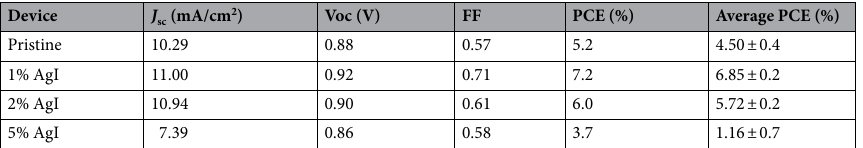
Table 1. Summary of PV parameters of the best performing devices together with the average PCE of the pristine and AgI based